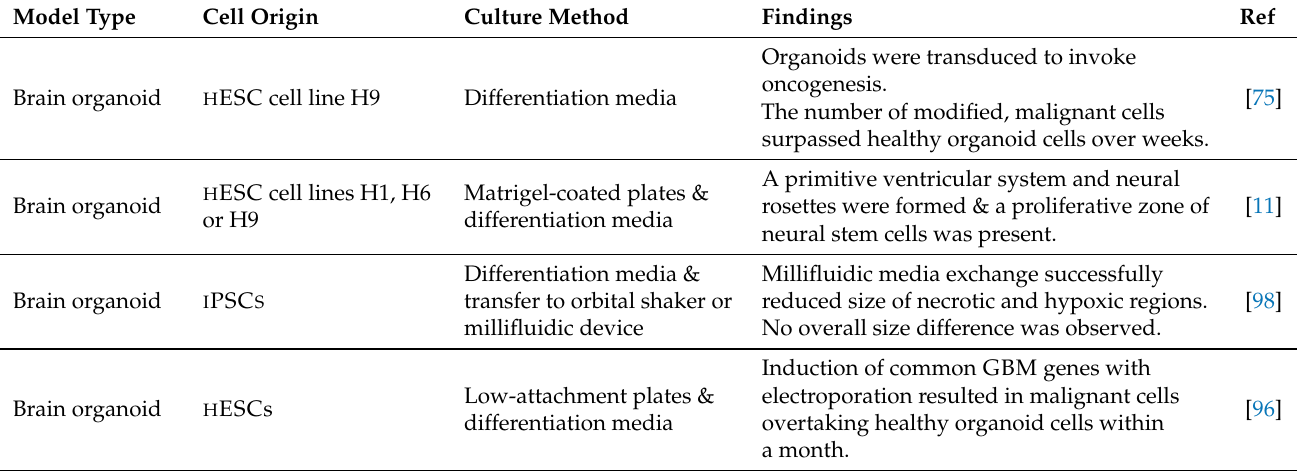
Table 5. Methods for the formation of BO S and the findings generated with their